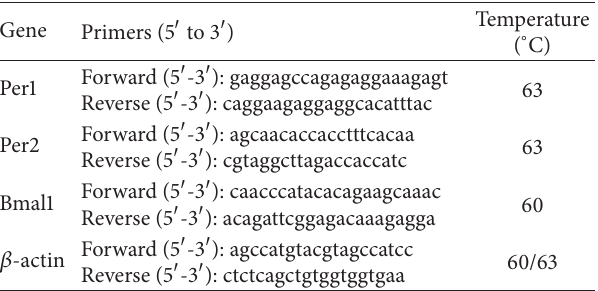
Table 1: RT-qPCR primers used for the analysis of clock gene